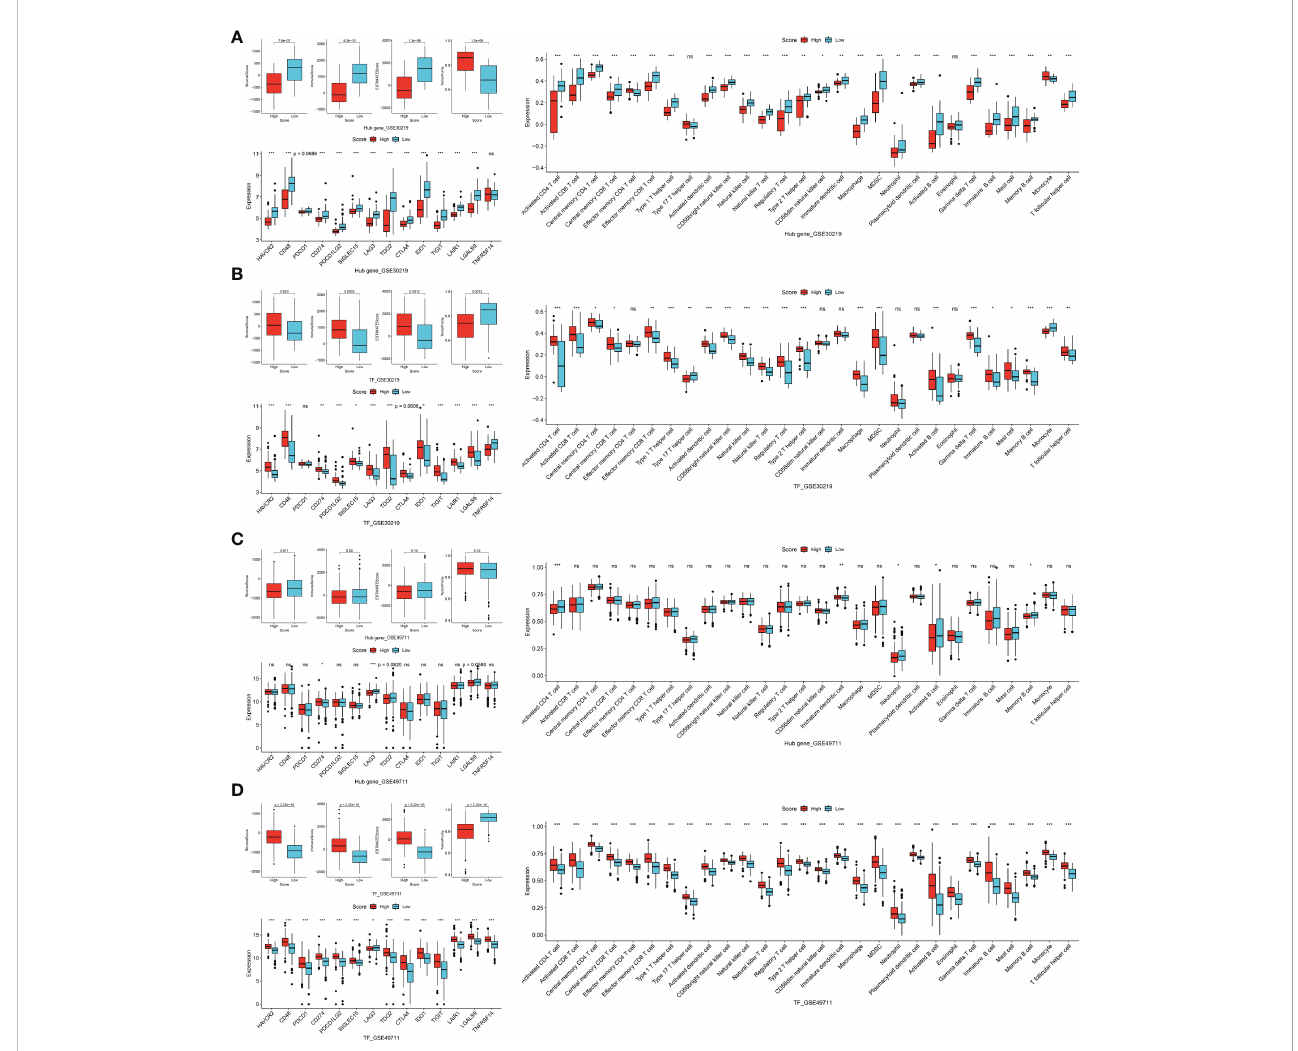
FIGURE 9 Correlation of TF, mRNA and miRNA scores in TF-mRNA-miRNA network with immune characteristics in neuroendocrine tumors. The relationships of hub-gene score (A) and TF score (B) with stromal score, immune score, ESTIMATE score, tumor purity, immune in fi ltration and ICGs in NEL. The relationships of hub-gene score (C) and TF score (D) with stromal score, immune score, ESTIMATE score, tumor purity, immune in fi ltration and ICGs in NBL. NEL, neuroendocrine tumor of lung; NBL, neuroblastoma. Ns, not signi fi cant. *p < 0.05; **p <0.01; ***p <